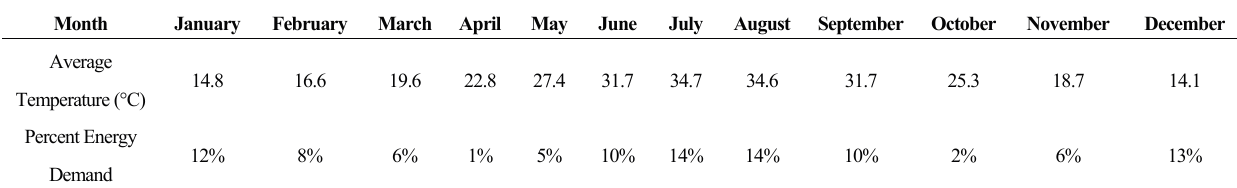
Table 2. Percent heating and cooling energy demand by